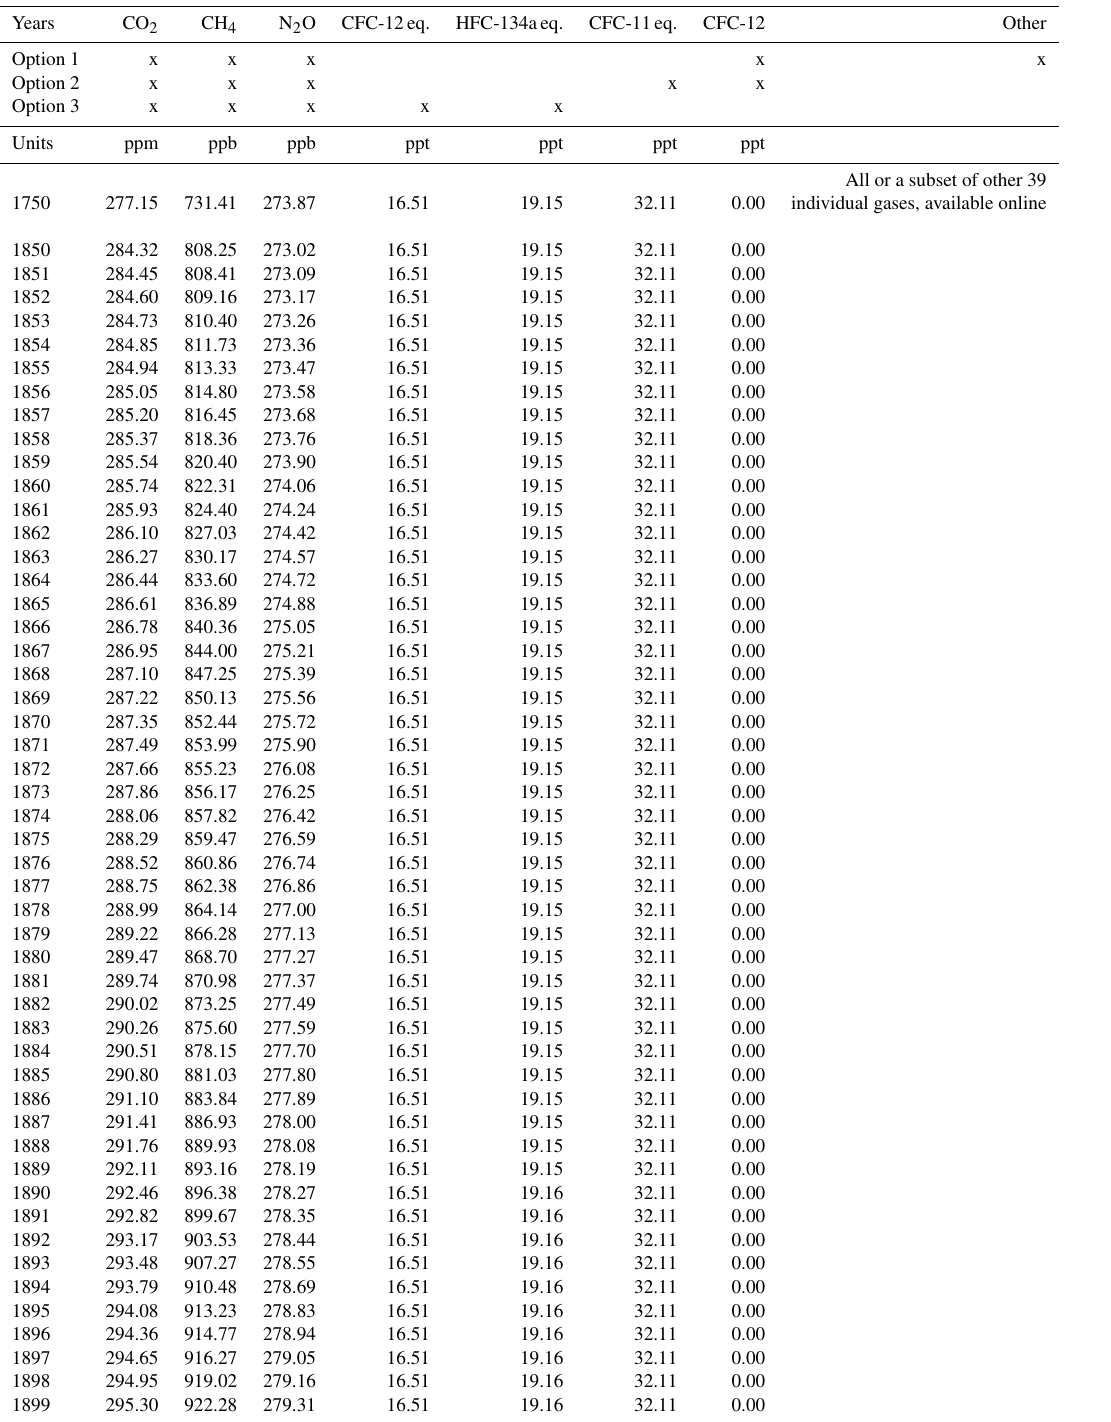
Table 6. Historical: global- and annual-mean surface concentrations for the historical CMIP6 experiments. The year-to-year and monthly resolved global, hemispheric and latitudinally resolved concentrations for 43 GHGs and three aggregate equivalent concentrations are pro- vided in the accompanying datasets over the time horizon year 0 (1BC) to year 2014 AD. The complexity reduction options for capturing all GHGs with fewer species than 43 are indicated in the table as Option 1, Option 2 and Option 3, with “x” denoting relevant columns under each option (Sect.